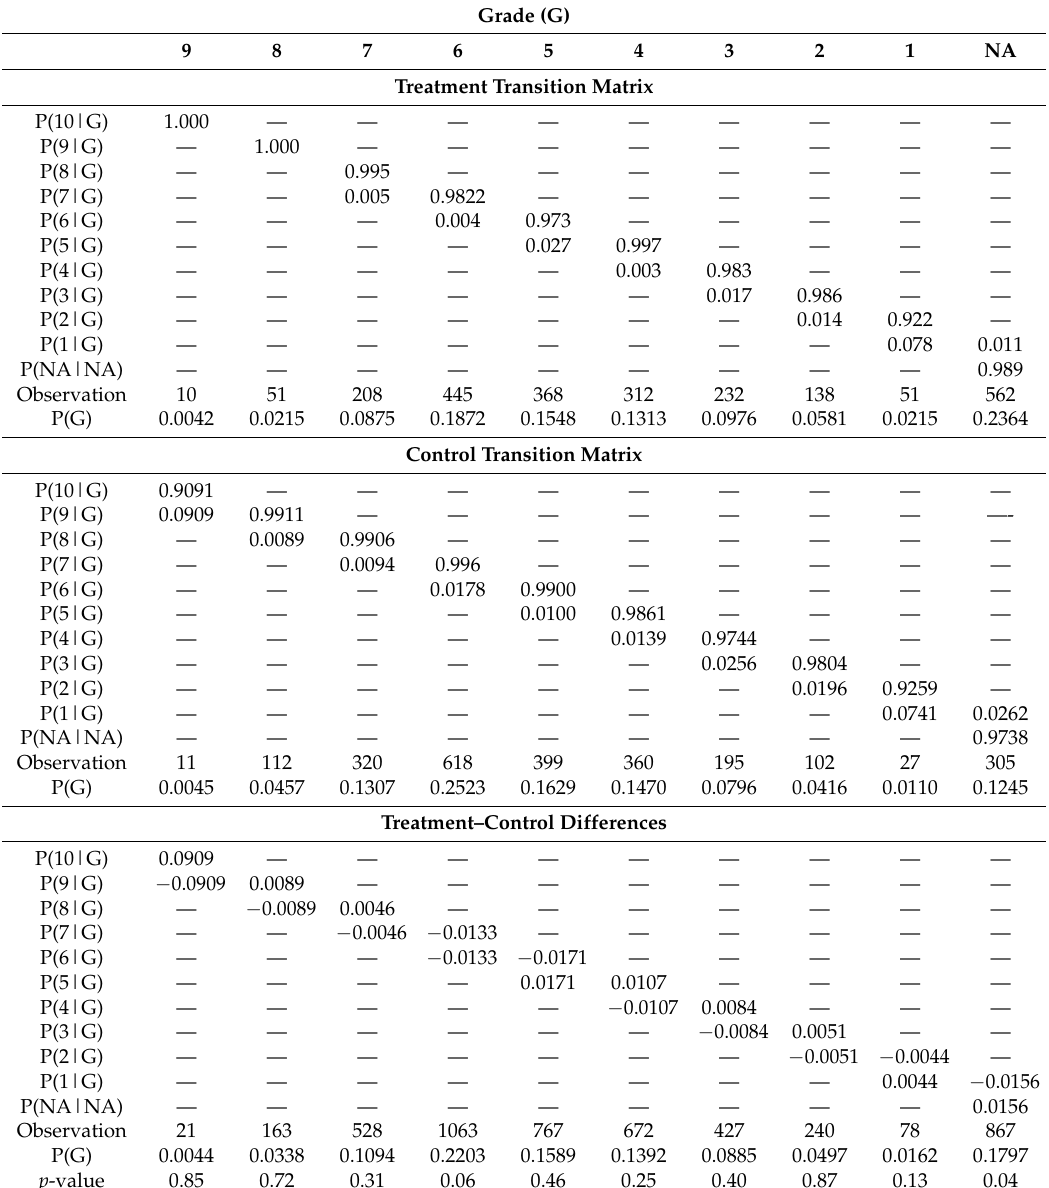
Table 6. Transition matrices (ages